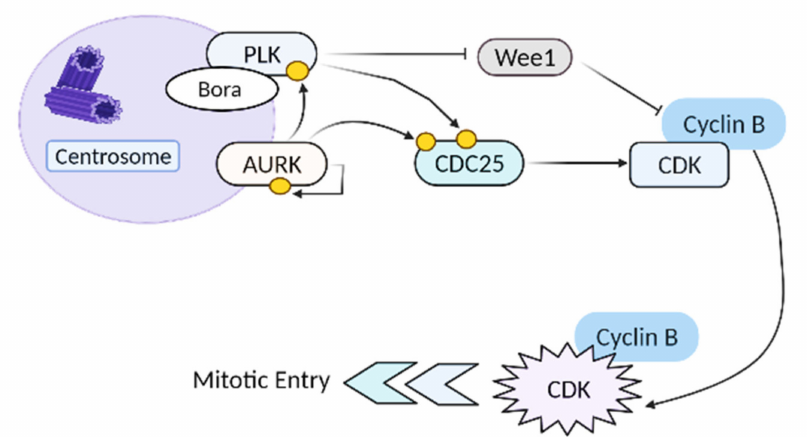
Figure 1. Schematic representation of the pathway induced by AURK and PLK. Both PLK and AURK phosphorylates CDC25 (cell cycle division 25), allowing CDK (cyclin-dependant kinase)/Cyclin B complex activation and thus permitting transition of the cell from the G2 phase to the M phase (mitotic entry). PLK facilitates this process by inhibiting the CDK inhibitor Wee1. Inactivation of PLK or AURK shows a marked delay in both CDK activation and mitotic